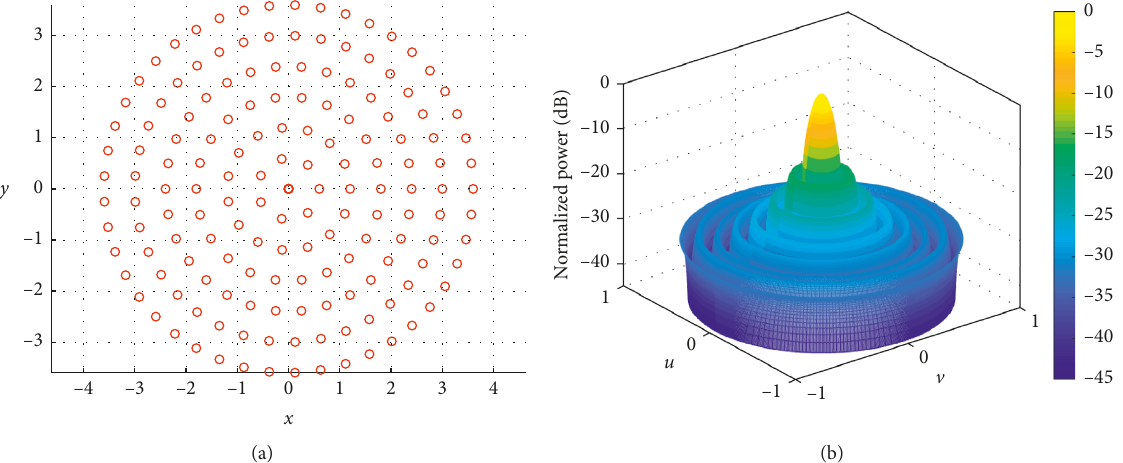
Figure 2: Uniform CRA. (a) Geometry of the CRA, of which ring spacing is 0 . 6 λ and elements spacing is 0 . 5 λ . (b) Radiation pattern, which has an excellent symmetrical